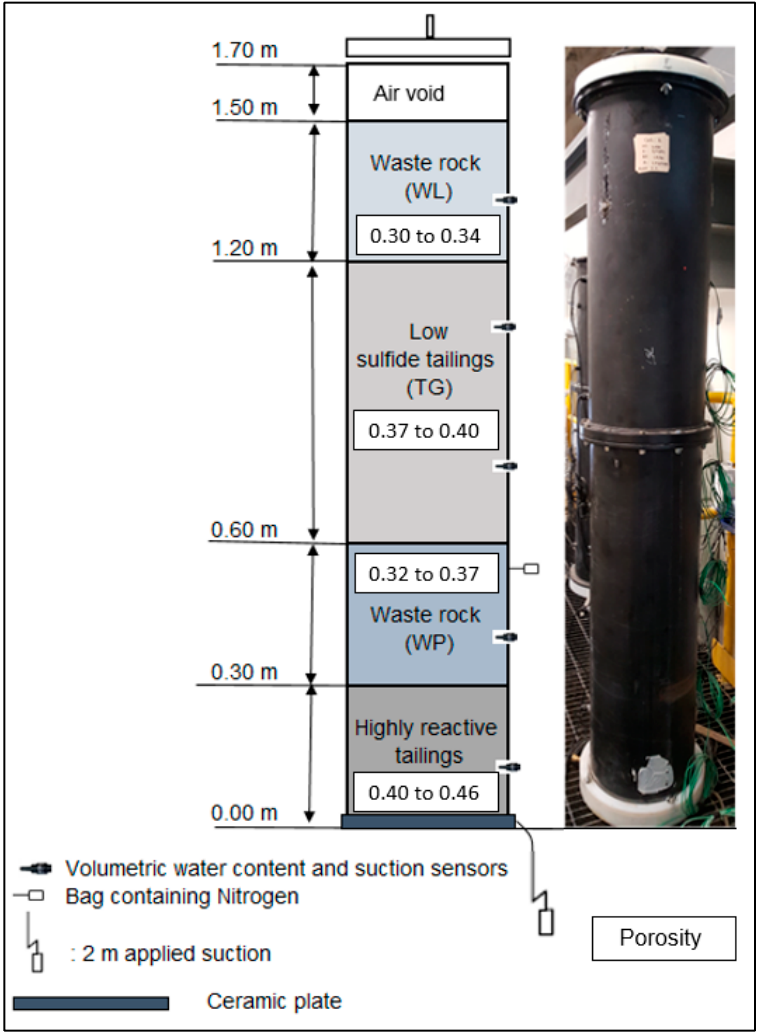
Figure 2 . Schematic of the cover with capillary barrier effects (CCBE) column and instrumentation. The laboratory column was equipped with 5TM and GS3 sensors and an Em50 data logger (version 4, Decagon Devices, Pullman, WA, United States) that recorded the volumetric water content ( θ ) at various depths in the tailings and waste rocks, respectively (Figure 2).